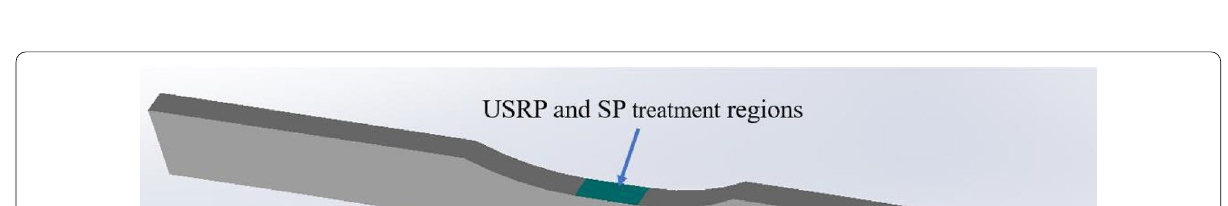
Figure 5 Geometric details of the specimen (units: mm)